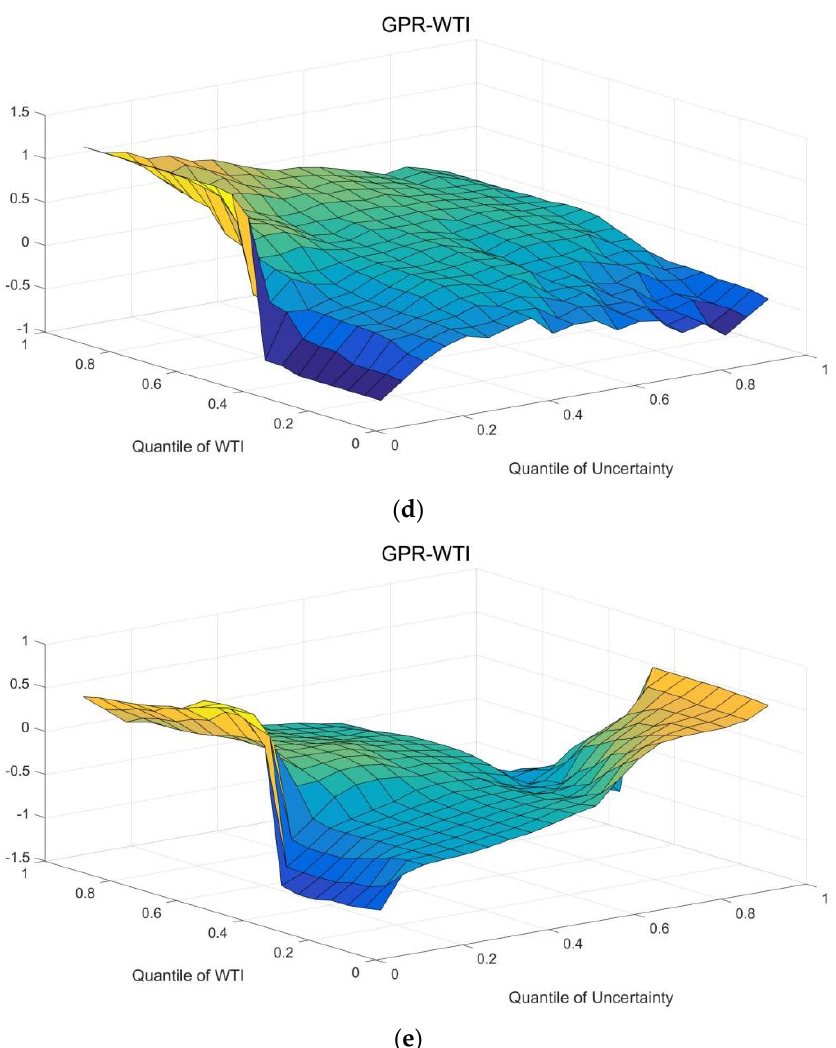
Figure 4. Estimation of the impact coefficients of the GPR on the WTI at different time scales. ( a ) The impact of the GPR on the WTI at D1; ( b ) The impact of the GPR on the WTI at D2; ( c ) The impact of the GPR on the WTI at D3; ( d ) The impact of the GPR on the WTI at D4; ( e ) The impact of the GPR on the WTI at D5.